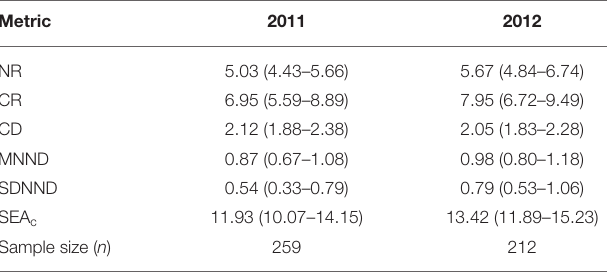
TABLE 3 | Stable isotope community metrics (mean with 95% CI in parentheses) comparing the trophic structure of fish communities sampled from Lake Liambezi in 2011 and 2012.